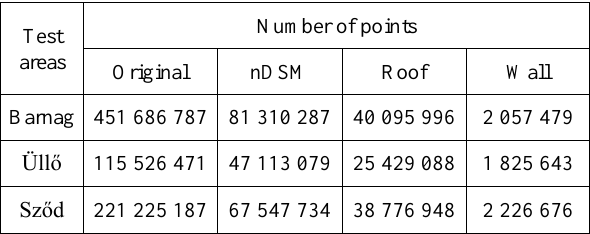
Table 1 . Size of the point clouds at the different steps, nDSM without ground points.